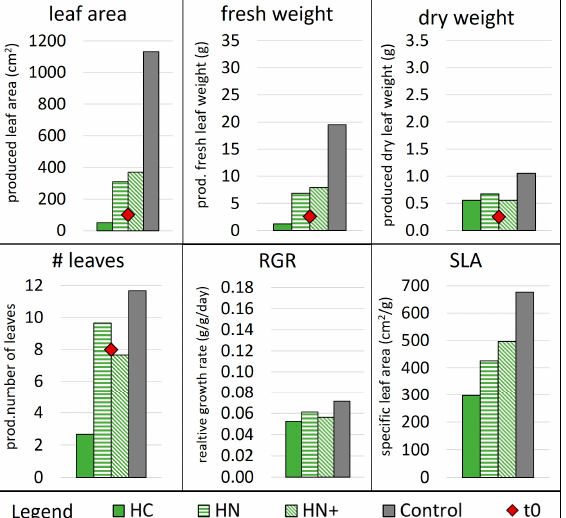
Figure 5. Plant growth parameters in week 3 of cycle 1. Number of leaves, leaf area, fresh and dry weight at t0 are indicated as red dots while the additionally produced quantities after 21 days are indicated as bars. Abbreviations: RGR, relative growth rate; SLA, specific leaf area. Reference for MgP salts: H, hazenite. Reference for acids: C, citric acid; N, nitric acid. +, supplemented with KNO 3 .